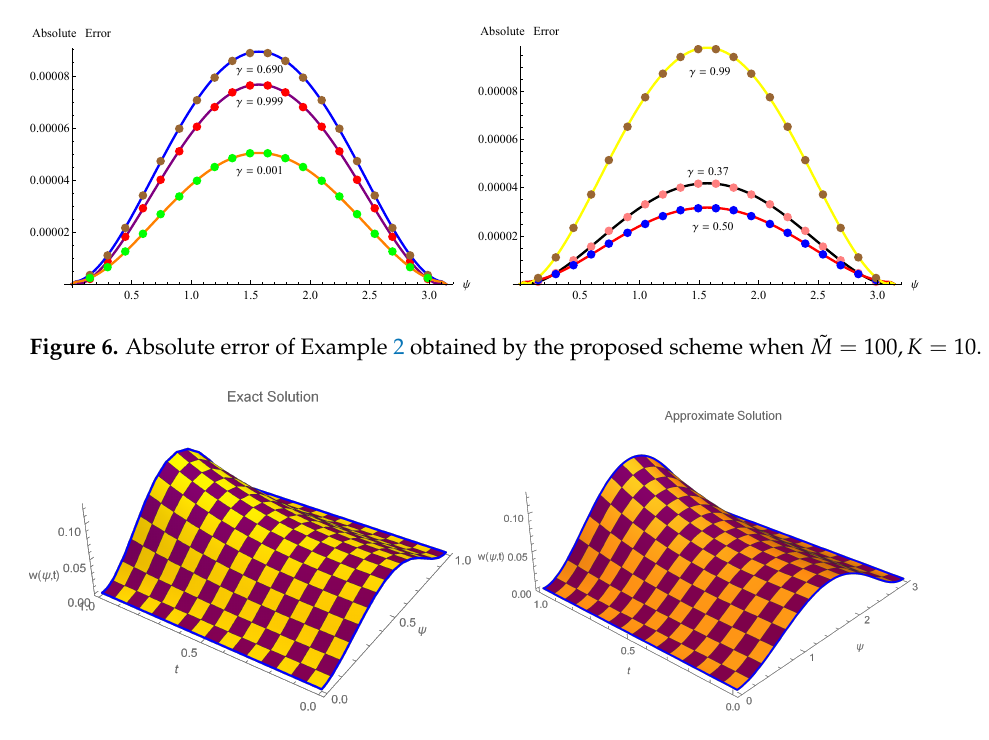
Figure 7. Three-dimensional analytic and approximate solutions of Example 2 obtained by the proposed scheme when γ = 0.001 and ˜ M = 100, K = 10.